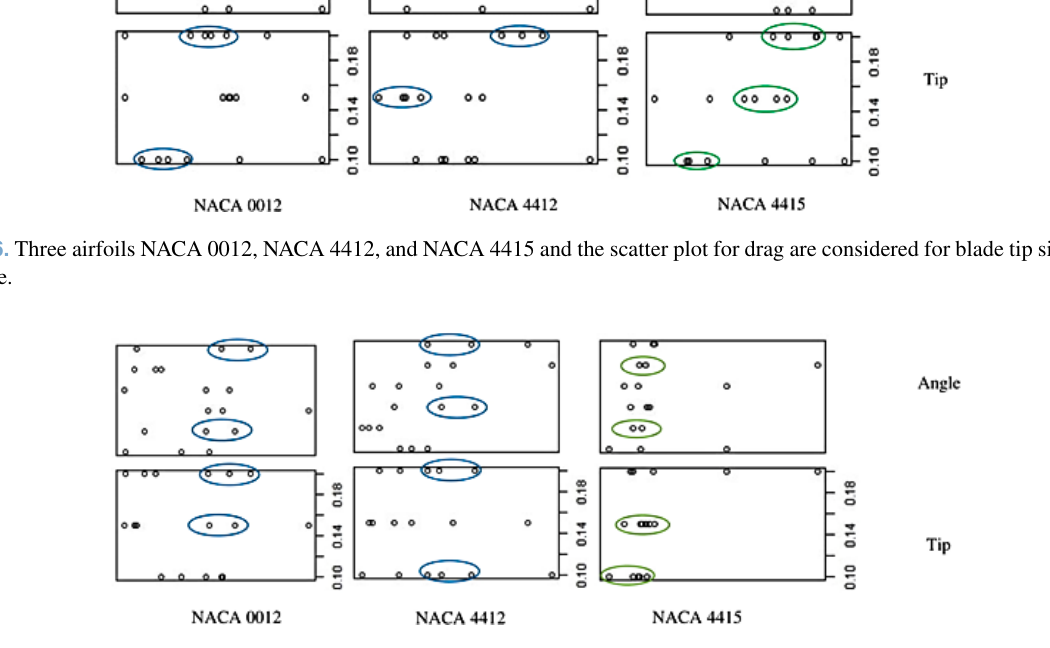
Figure 17. Turbulence intensity scatter plot for blade angle and blade tip size of airfoils NACA 0012, NACA 4412, and NACA